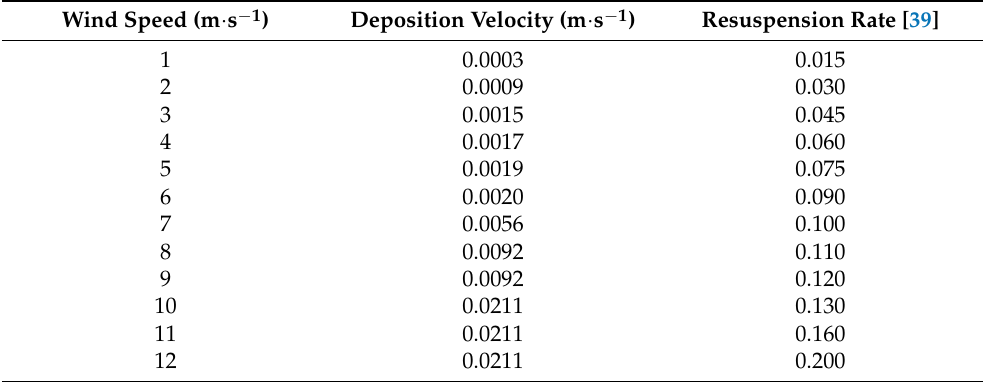
Table 2. Deposition velocities and resuspension rates (taken from [39]). of PM 2.5 by wind speed per unit leaf